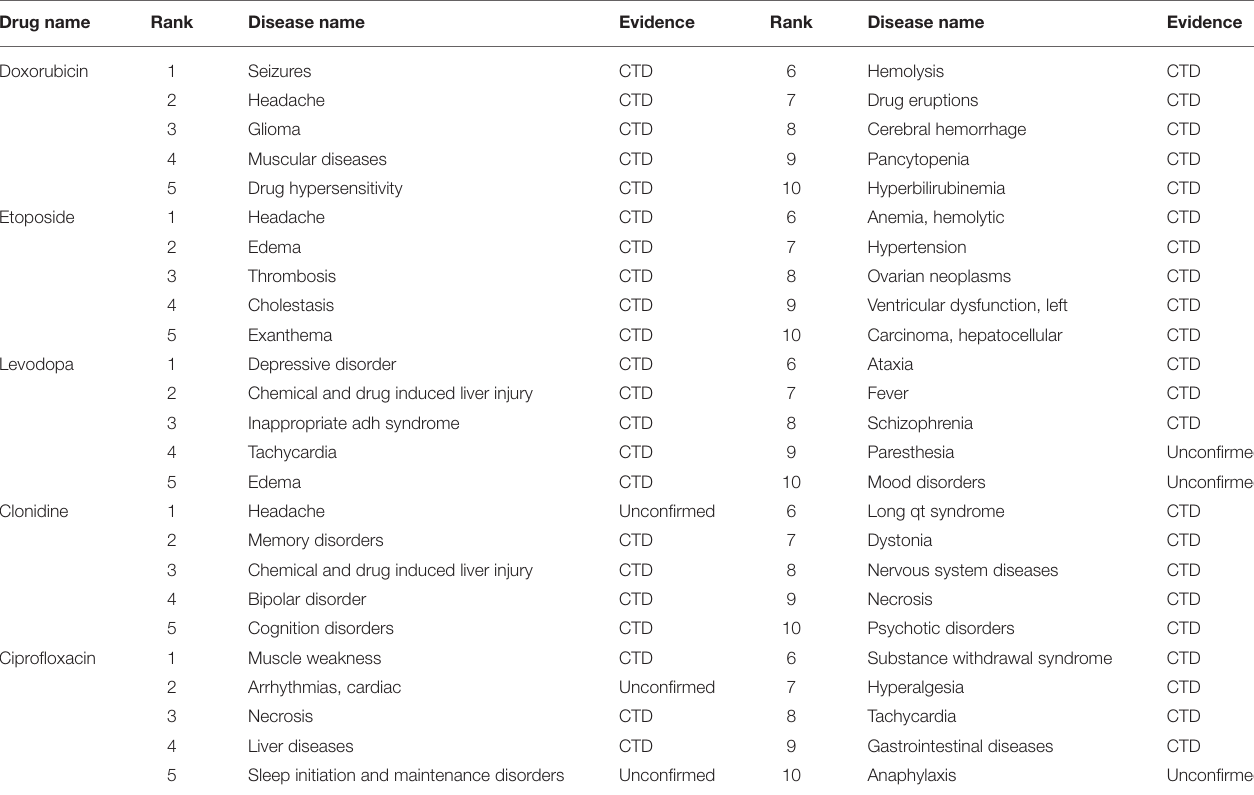
TABLE 4 | The top 10 drug candidates of the five popular drugs supported by MGRL. Drug